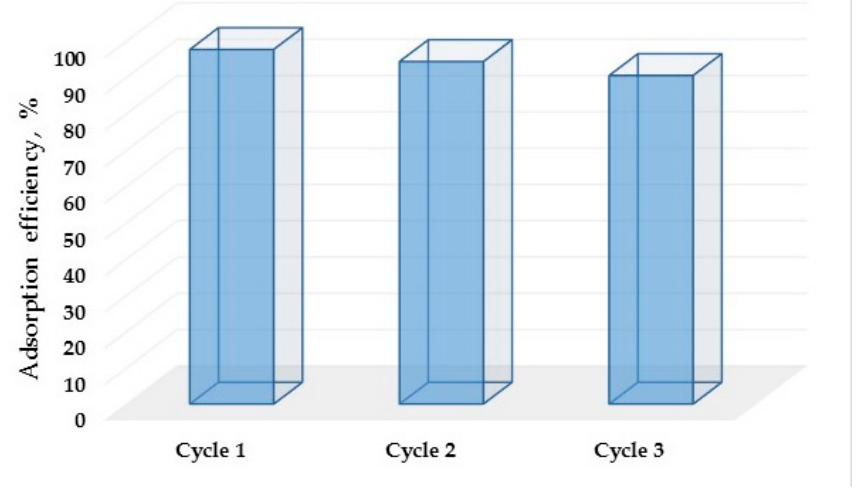
Figure 8. Adsorption efficiency of the synthesized material. From Figure 8, it is clear that the adsorption efficiency of the material drops a little after each cycle. This might be due to the amount of the adsorbent lost during the adsorption process. After three cycles the adsorption efficiency is still 90%, which made the synthesized adsorbent appropriate for use in wastewater treatment loaded with the copper